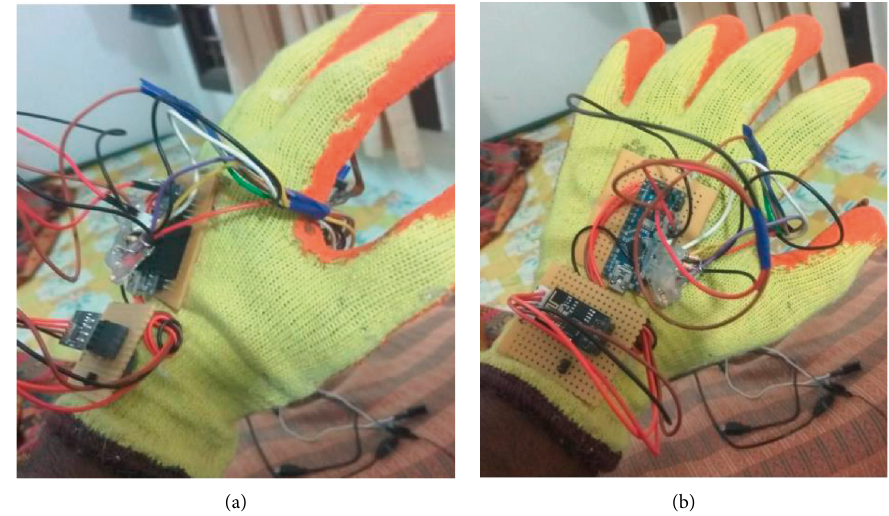
Figure 4: (a) Flex sensor interfaced in glove. (b) Human finger gesture detection using flex